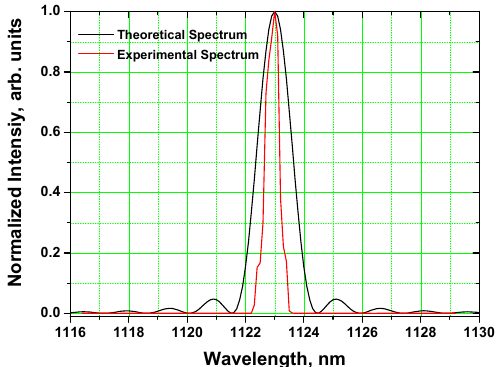
Figure 2. The normalized efficiency versus the fundamental wavelength (black line) and the actually measured spectrum of the fundamental light (red line).